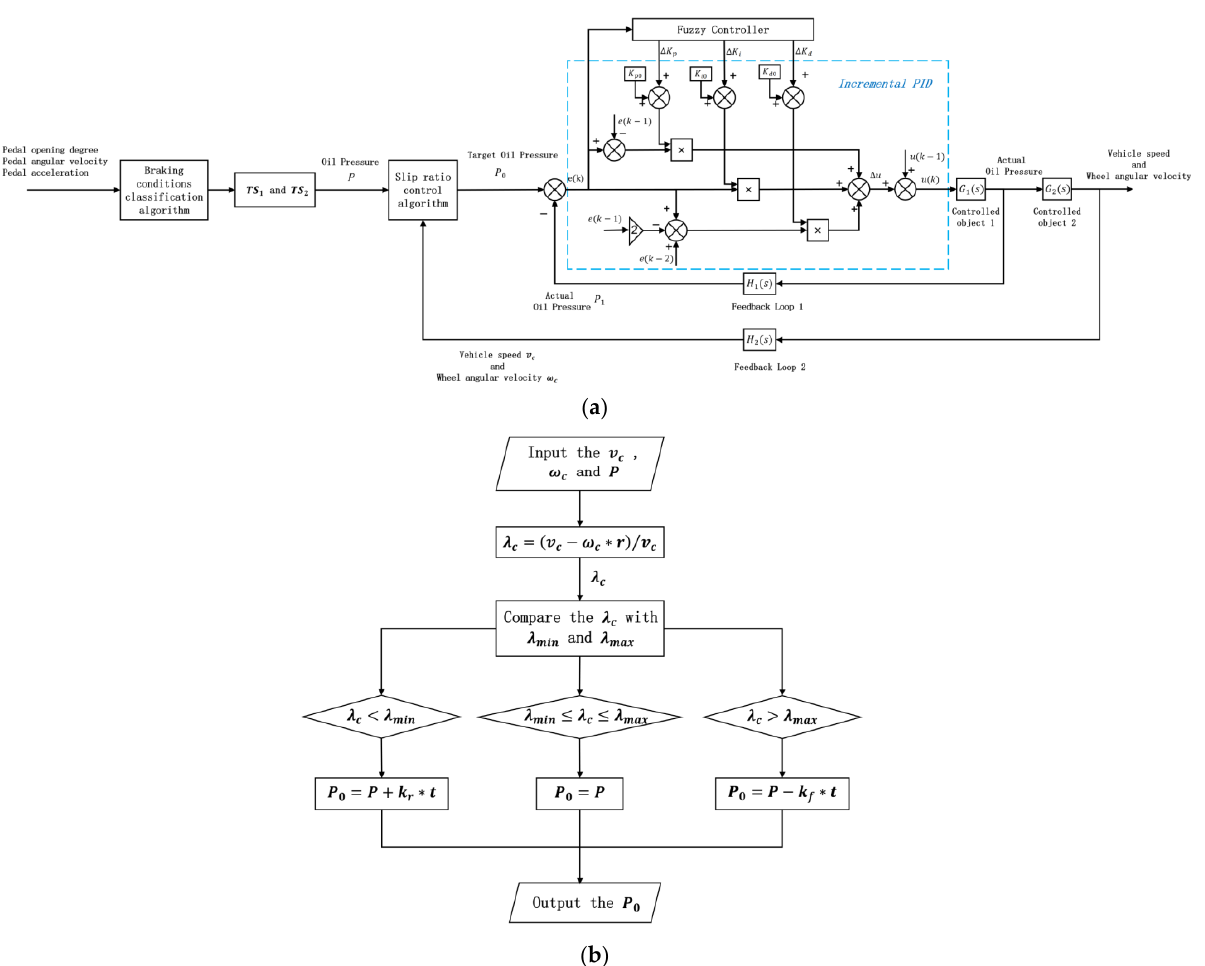
Figure 14. Improved target oil pressure following control method: ( a ) The combination of target oil pressure following control method and slip ratio control algorithm. ( b ) Slip ratio control algo- rithm.